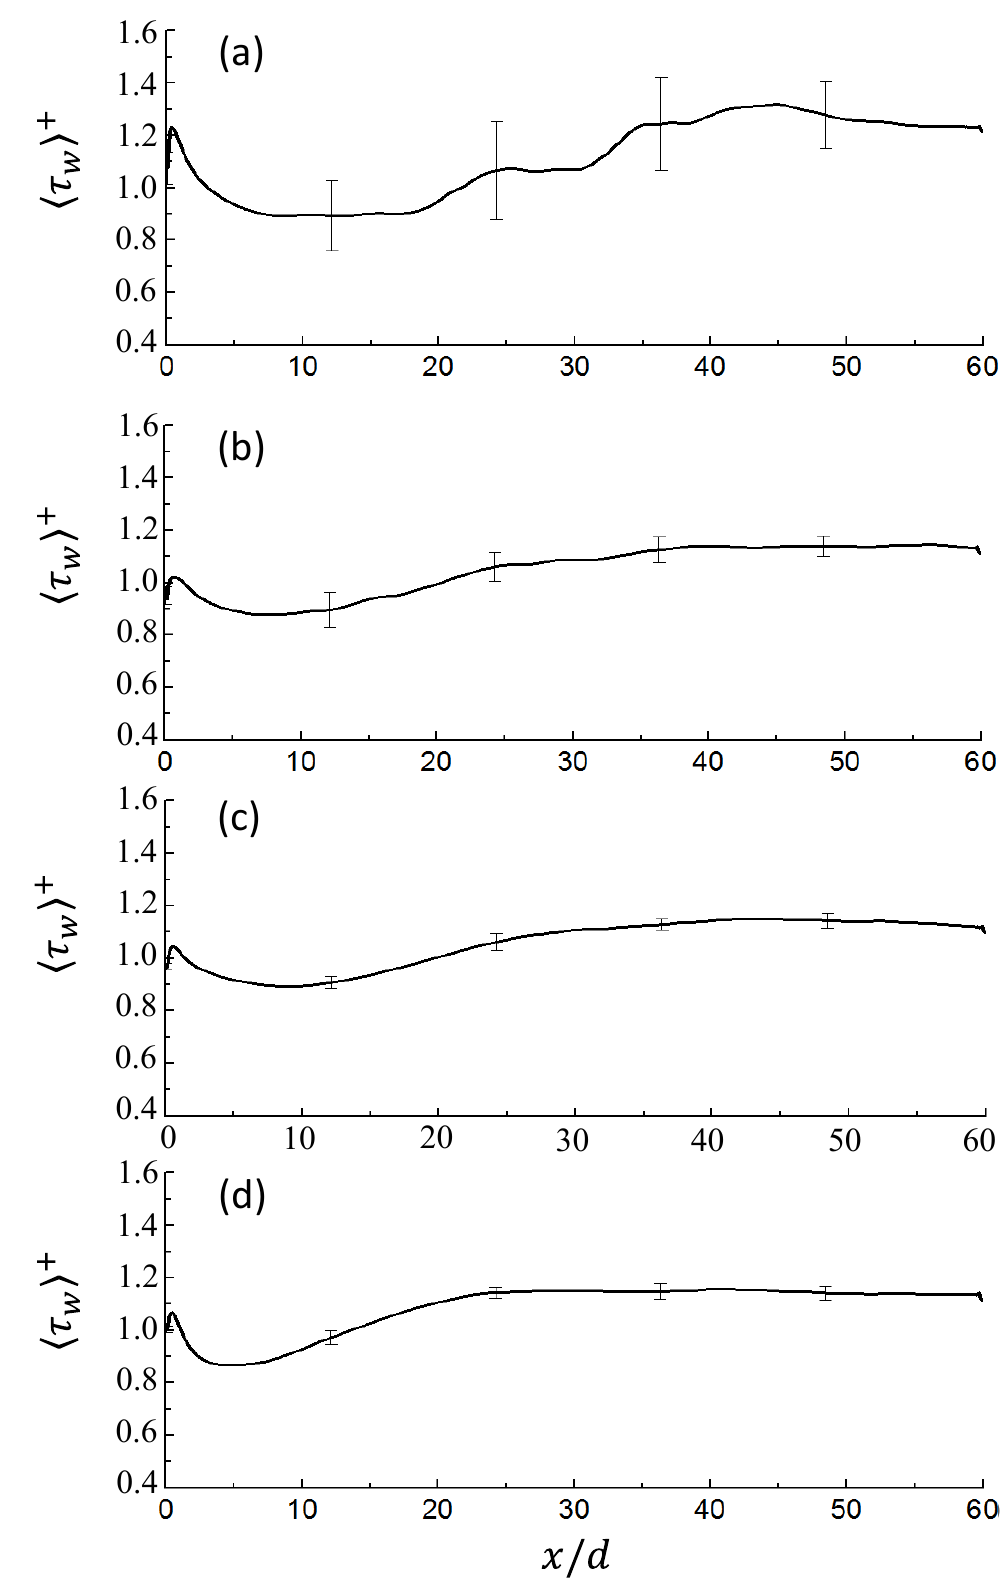
Figure 9. Variation of dimensionless wall shear stress and deviation in the domain with changing length scales for ( a ) Case 05, ( b ) Case 06, ( c ) Case 01, and ( d ) Case